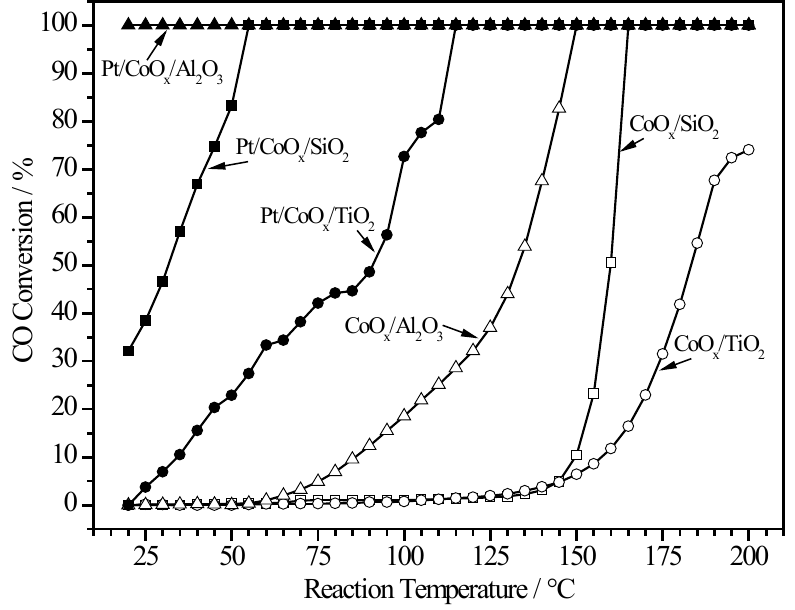
Figure 7. CO conversions on Pt/CoO x /SiO 2 , Pt/MO x /TiO 2 and Pt/CoO x /Al 2 O 3 catalysts as a function of reaction